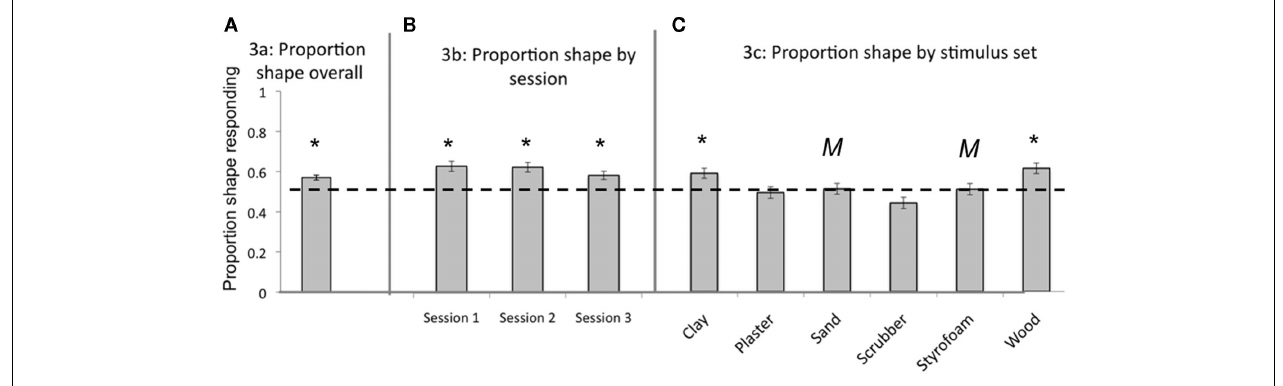
FIGURE 3 | (A) Overall proportion shape responding in novel noun generalization. (B) Proportion shape responding for each session. (C) Proportion shape responding for each stimulus set.